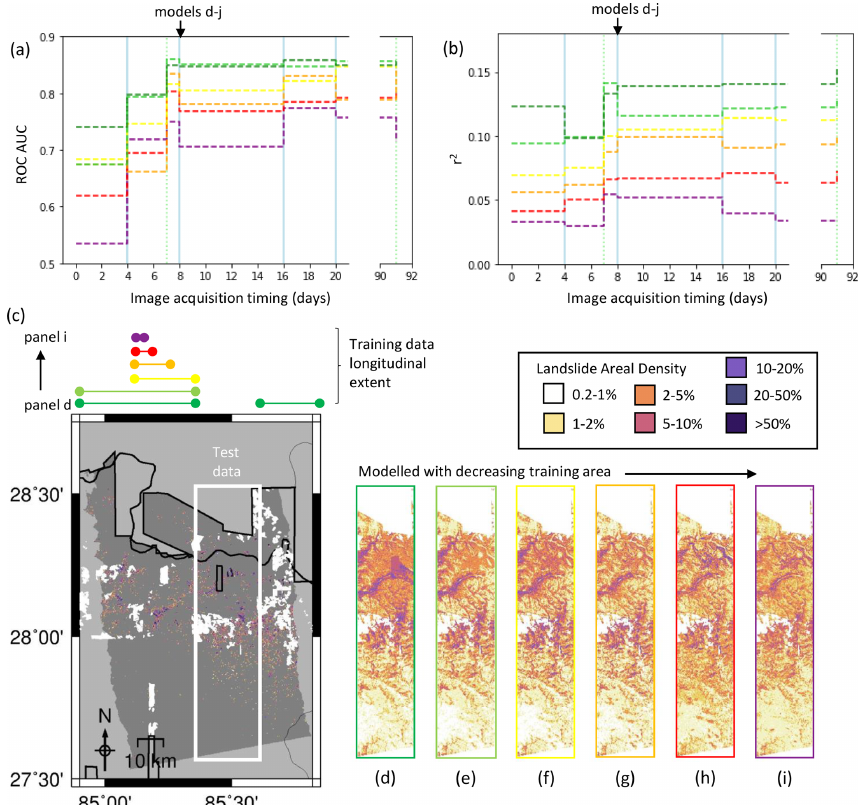
Figure 7. The effect of altering the extent of the training data in terms of ROC AUC (a) and r 2 (b) . The colours of the lines in panels (a) and (b) correspond to the lateral extent of the training data marked on panel (c) . (c) The mapped landslide inventory for the 2015 Gorkha earthquake of Roback et al. (2017), reproduced as landslide areal density for 200 × 220m pixels. (d–i) Modelled landslide areal density with decreasing areas of data used for training the